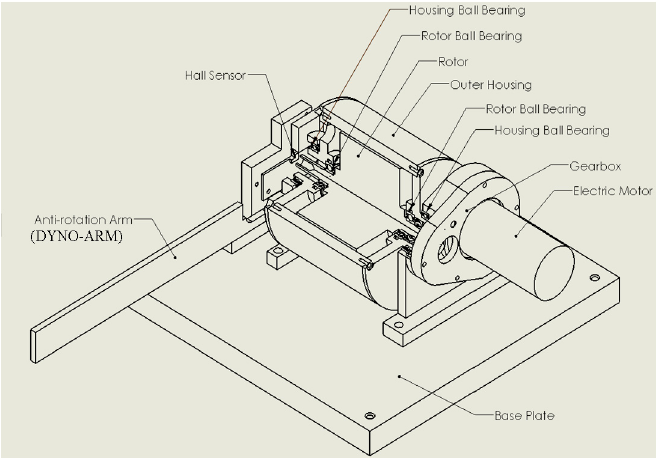
Figure 2. Experimental apparatus nomenclature.